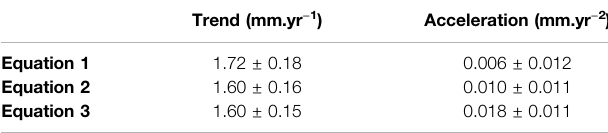
TABLE 1 | The estimated trends and accelerations by Eq. 1 to Eq. 3 . The acceleration estimated by Eq. 3 is the only statistically signi fi cant one. Trend (mm.yr − 1